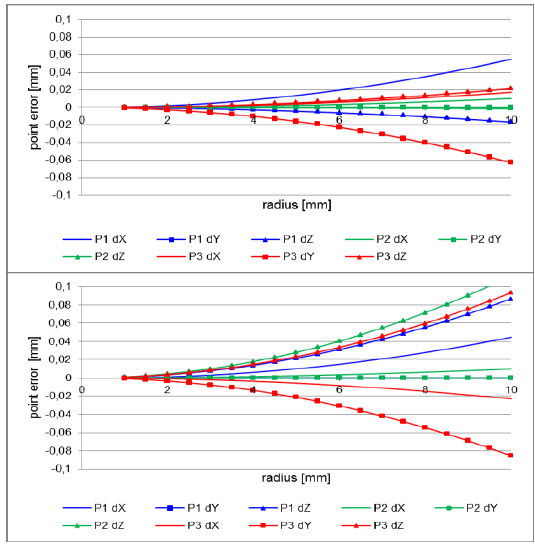
Figure 14: 3D point errors as a function of spherical target radius for normal case (left) and convergent stereo case (right) Figure 14 shows the errors of spatial intersection caused by eccentricity of a spherical target. For the normal stereo case, point P1 shows larger errors in X than in Z, while Y is calculated correctly. The same effect occurs for P2 but with smaller values since the point is further away from the cameras. P3 shows errors in all directions. In general, 3D point errors